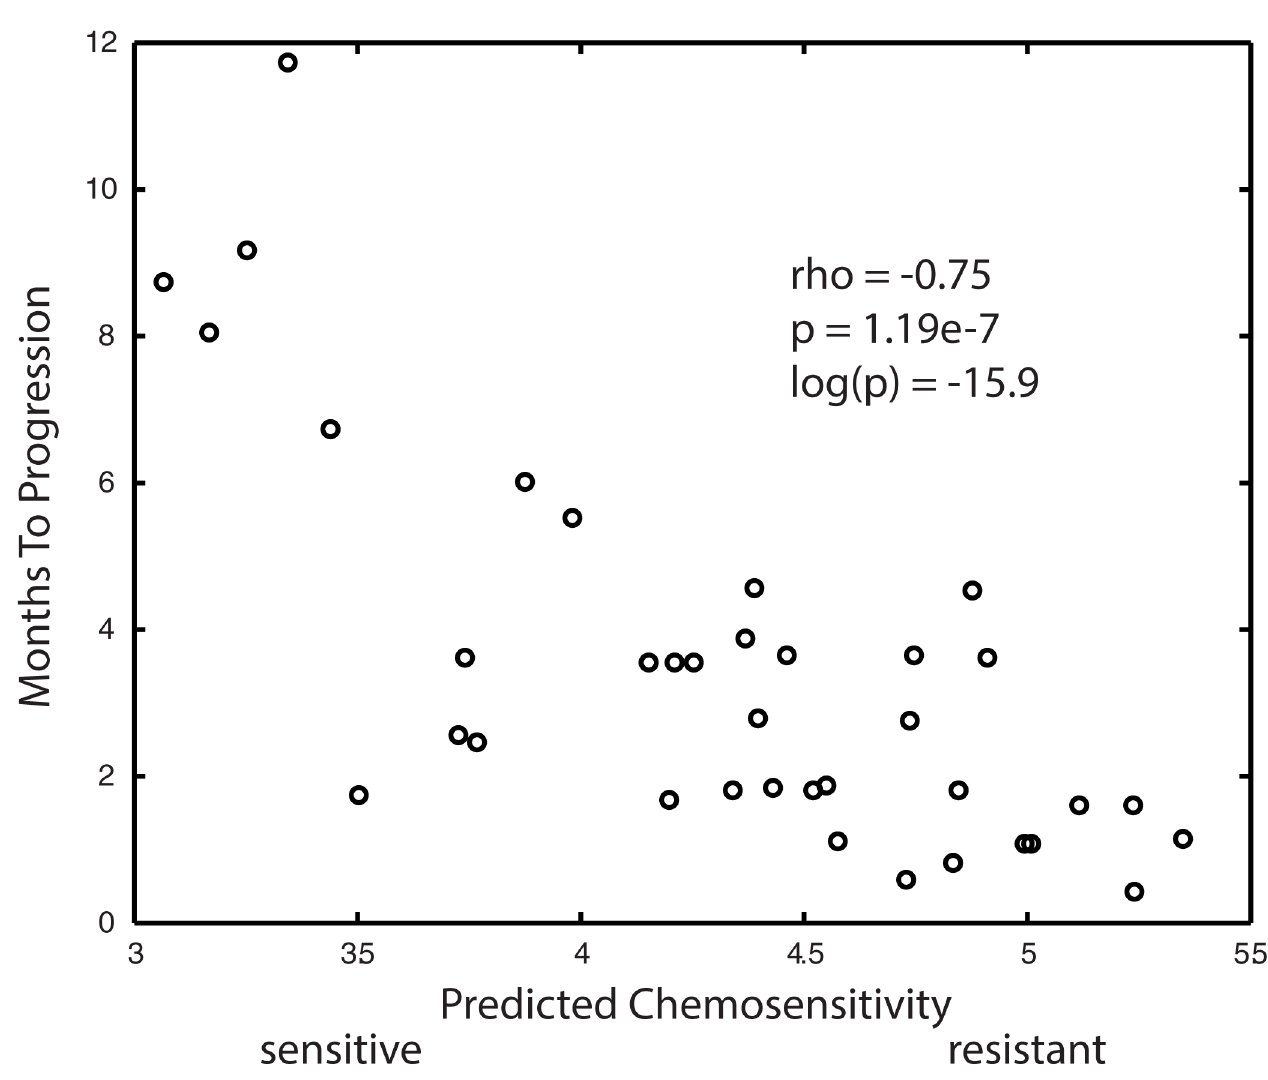
Fig 3. Plot represents the averageperformance of the 48 linear ridge models selectedby dual filtering of the random simulations based on goodness of fit of the predicted preclinical sorafenib IC 50 data with averagedgene expressions (training data) and goodness of model fit to the clinical outcome for 37 BATTLE patients receiving sorafenib (test data). X-axis representsthe modelpredictedchemosensitivity when usingthe BATTLE geneexpressionsin the trainingmodel.Y-axis represents the patient’s observedMonths to Progression. Correlativestatistics appearin the upperrightregionof the